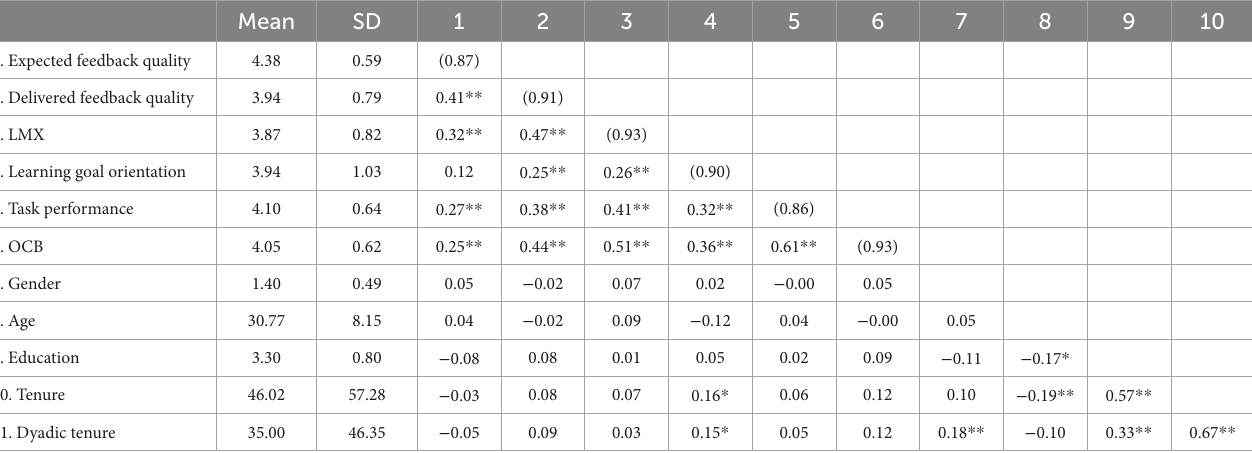
TABLE 1 Descriptive statistics and variable correlations.